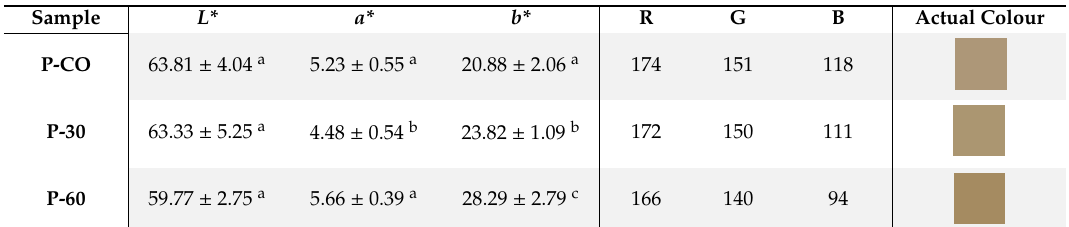
Table 3. Colour parameters (L*, a*, b*) with RGB conversion of pâté samples (P-CO: control sample; P-30 and P-60: samples with 30% and 60% of pork fat replacement, respectively).